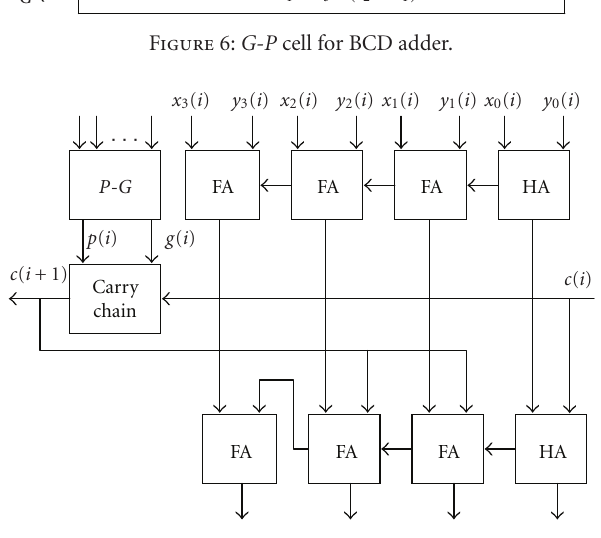
Figure 7: Carry-chain BCD adder i th